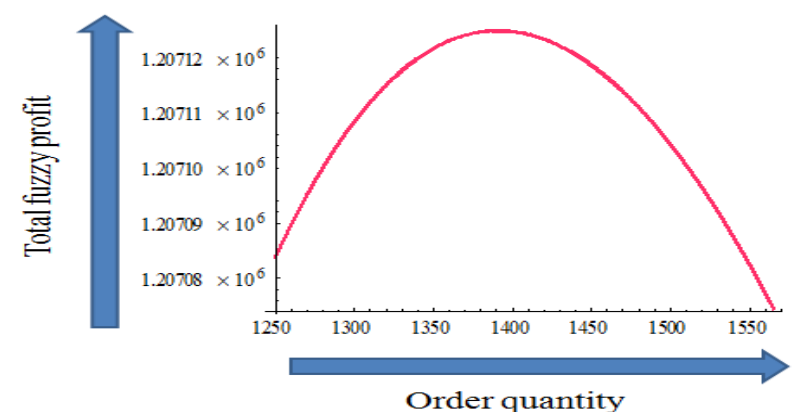
Figure 7. Concavity of total fuzzy profit for Scenario-1.